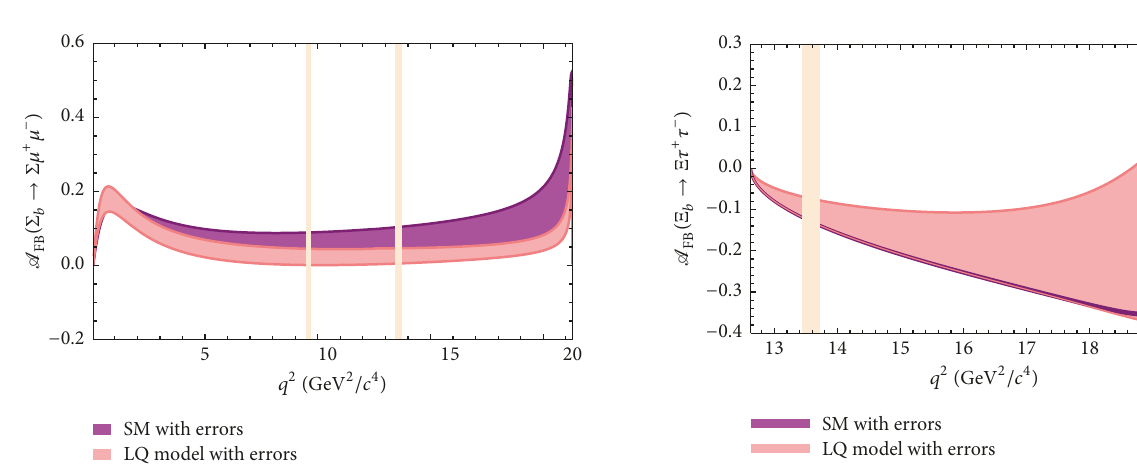
Figure 9: The dependence of A FB on 𝑞 2 for the Σ 𝑏 → Σ𝜇 + 𝜇 − transition in the SM and LQ models. The vertical shaded bands indicate the charmonia veto regions.